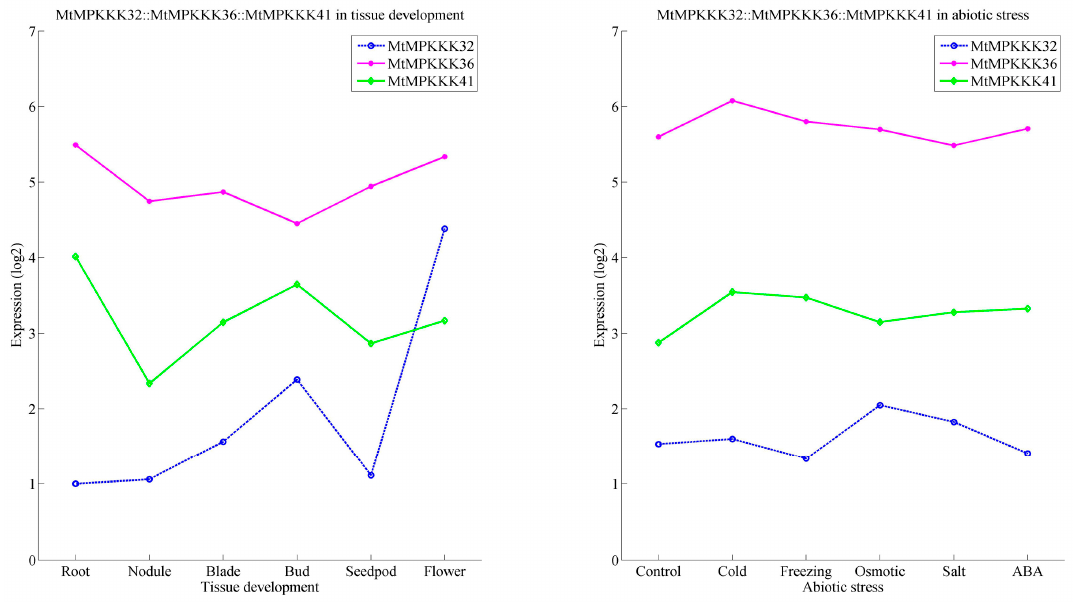
Figure 6. The expression profiles of MtMAPKKK32::36::41 involved in tissue development and response to abiotic stress.